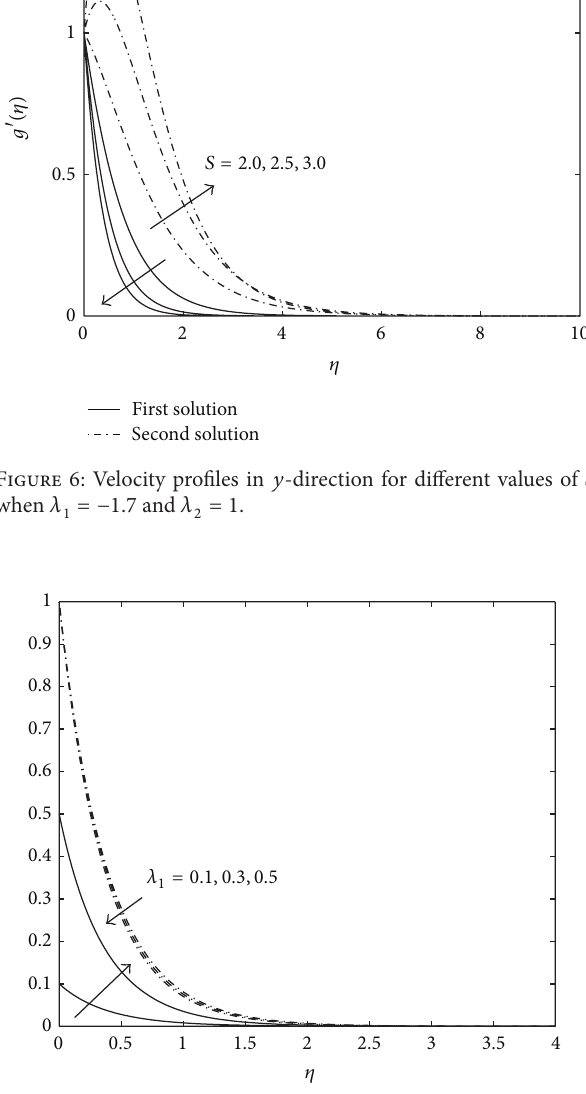
in the 𝑦 -direction. As thermophoresis parameter and Lewis number increase, the local Nusselt number decreases. On the other hand, the local Nusselt number increases as Brownian motion parameter increases.